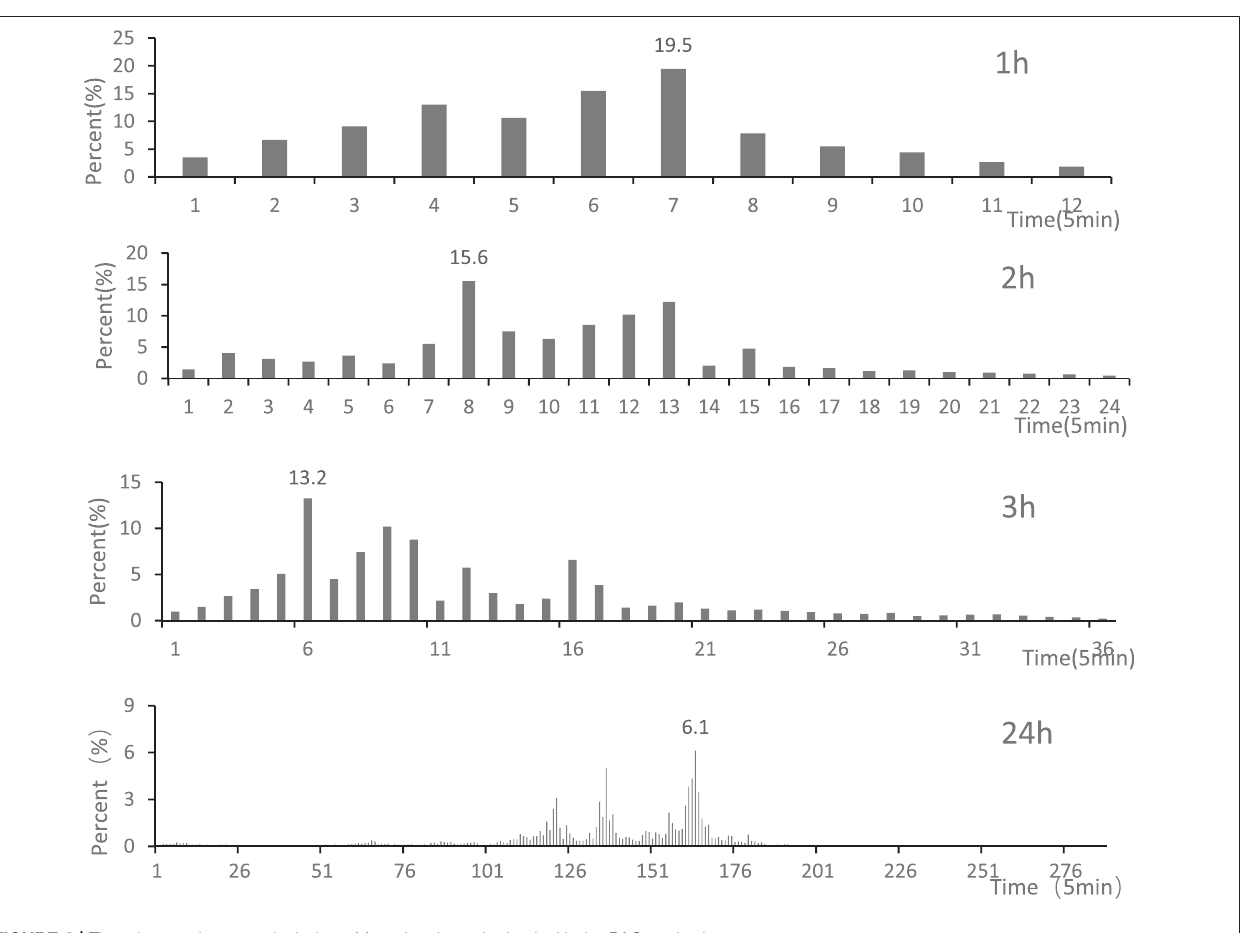
Frontiers in Environmental Science |